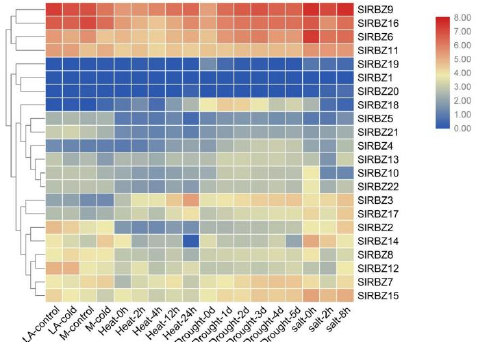
Figure 8. Expression patterns of SlRBZ genes under abiotic stresses based on RNA-seq. Moneymaker (M) and LA1777 (LA) were treated for 3 d at 23 ℃ and 15 ℃ . Under heat and drought conditions, the seedlings of Solanum lycopersicum cv M82 were kept under 42 ℃ and the drought treatment, respectively. In salt, the seedlings of Micro-Tom were sprayed with 200 mM NaCl.